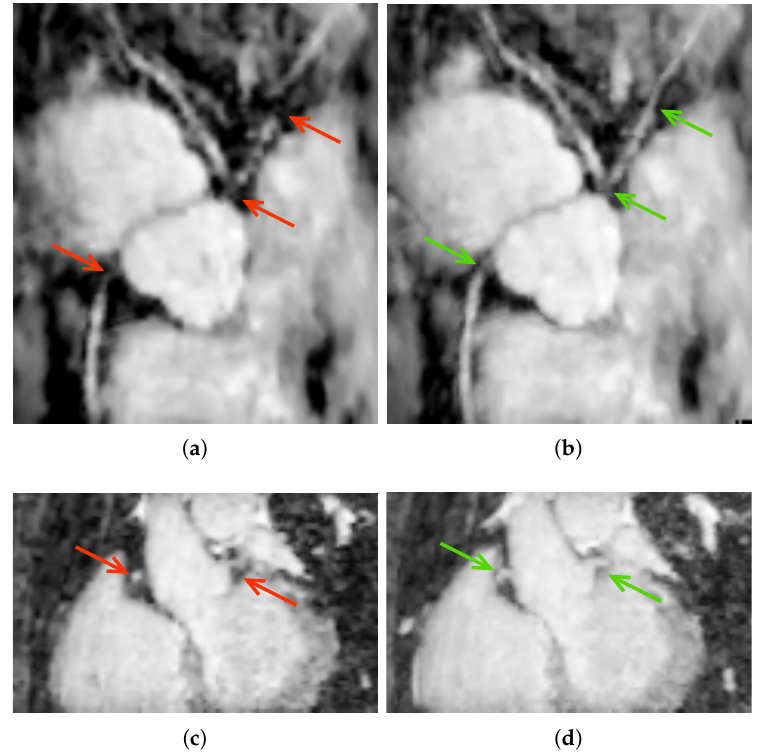
Figure 5. Generated curved (top row) and multiplanar (bottom row) reformatted images without ( a ), ( c ) and with ( b ), ( d ), maximum intensity projection applied. Red and green arrows denote points were the application of MIPs improved vessel visualization.